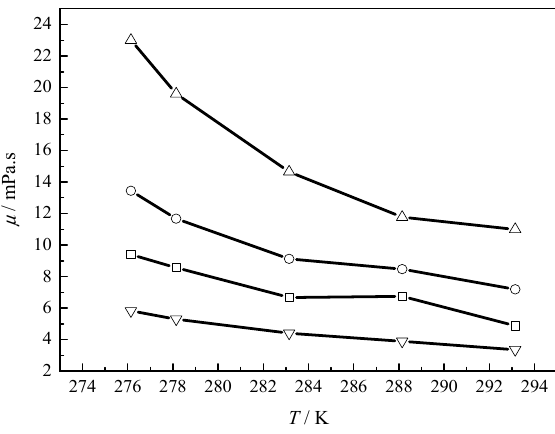
Figure 1. Viscosity of ( ▽ ) diesel oil and water-in-oil emulsion with anti-agglomerant (AA)-1 for a water cut of ( □ ) 10 vol %; ( ○ ) 20 vol %; ( △ ) 30 vol %. Lines are provided to guide the eye.